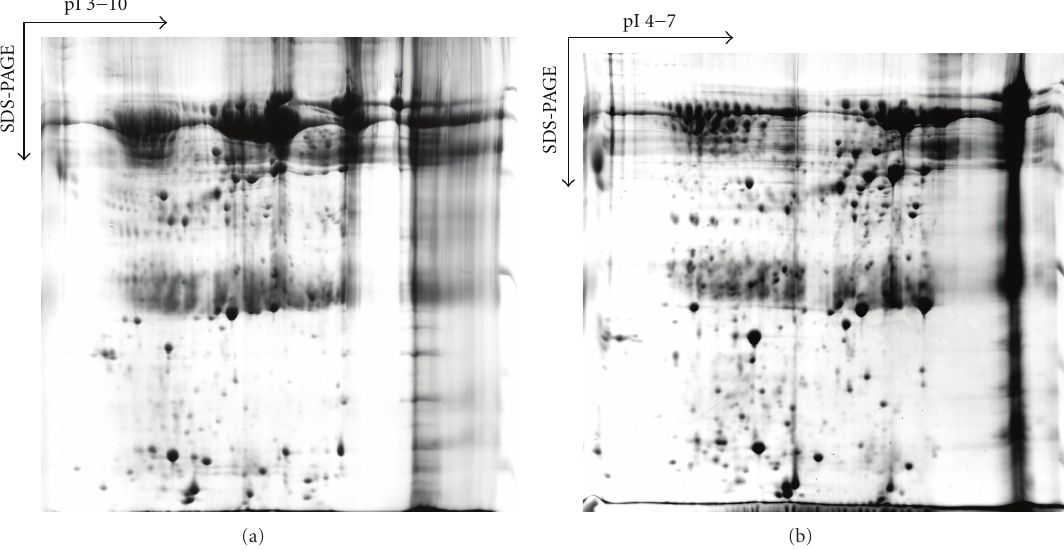
Figure 2: 2DE patterns after lung cancer formation. They were acquired by separating plasma of rats with lung cancer using pH3–10 (a) and pH4–7 (b) IPG strips, showing there were many protein spots and the number of protein spots in (a) was more than that in (b) obviously.